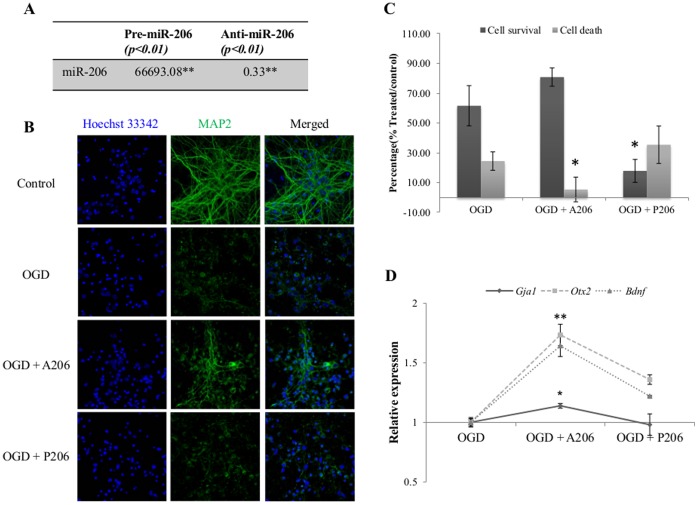
Cell viability and corresponding gene expression in primary neuronal culture transfected with anti-miR-206 or miR-206 mimic during reperfusion following OGD.(A) miR-206 expression is significantly increased in the presence of miR-206 mimic (p<0.01) and significantly decreased when cells were transfected with anti-miR-206 (p<0.01) during reperfusion. Expression value was calculated as relative expression compared to vehicle transfected controls. (B) Neurons subjected to OGD displayed increased apoptosis and degenerated neurites. Cells transfected with anti-miR-206 after OGD showed increased cell survival and maintenance of neurites as compared to cells subjected to OGD. Cells transfected with pre-miR-206 displayed increased cell death and degeneration of neurites as compared to cells subjected to OGD only. (C) Cells transfected with anti-miR-206 (A206) demonstrated significantly reduced cell death compared to cells subjected to OGD and transfected with vehicle (p<0.05), whereas cells transfected with miR-206 mimic (P206) showed significantly increased cell death compared to cells subjected to OGD transfected with vehicle (p<0.05). (D) Expression of Gja1, Otx2 and Bdnf showed negative correlation to miR-206 expression. Expression of Gja1 (p<0.05), Otx2 (p<0.01) and Bdnf (p<0.01) significantly increased in neuronal cells that were transfected with anti-miR-206 during reperfusion period. Relative expression (2−ΔΔCt) was calculated based on vehicle transfected controls as calibrator and GAPDH as endogenous control. A206 denotes anti-miR-206; P206 indicates pre-miR-206.